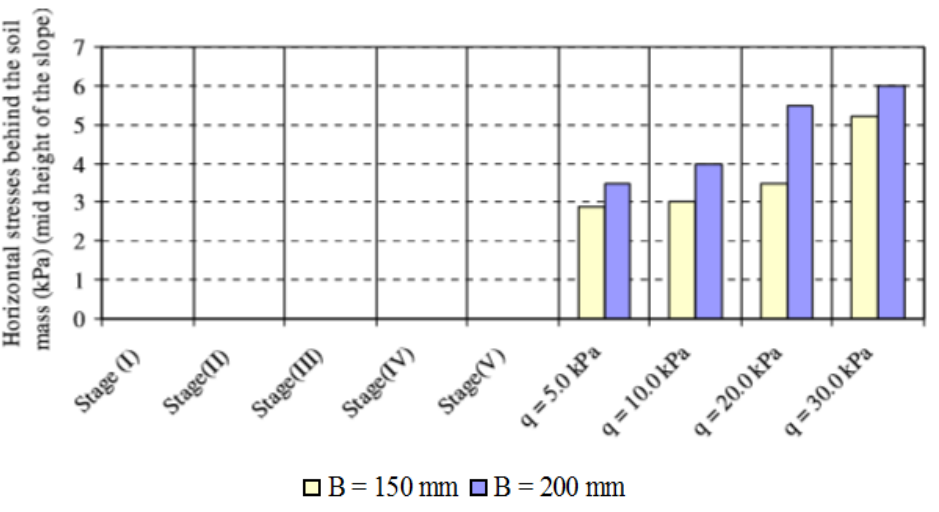
Figure 24. Influence of footing width on horizontal stresses behind the nailed soil mass at mid-height of slope.